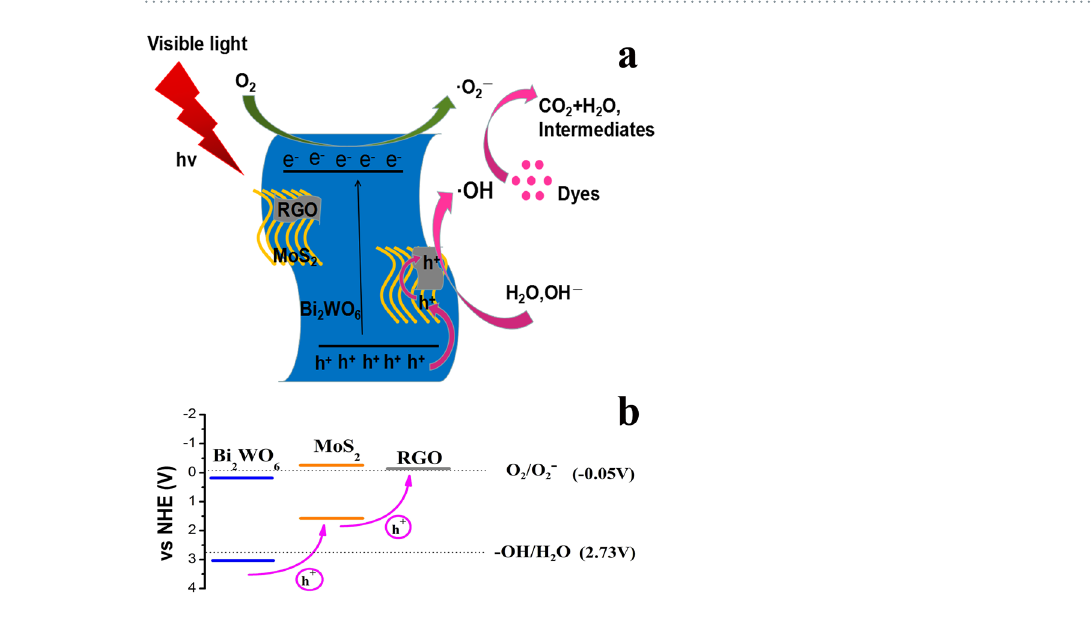
Figure 7. ( a ) Schematic diagram for photocatalytic mechanism of BWO/MG hybrids; ( b ) band structure, RGO, CB and VB levels of MoS 2 and